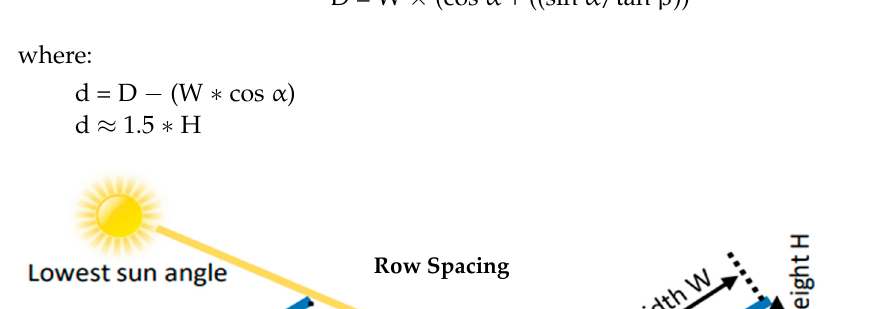
Figure 6. Tilt angle dimensions. Calculations of minimum values are shown in Equation (7); the minimum sun altitude angle β is on 21 December, which is when the worst shading occurs, β = 90°, Earth’s axis tilt angle ≈ 66.56° latitude. Figure 7 shows the minimum raw spacing dimensions.